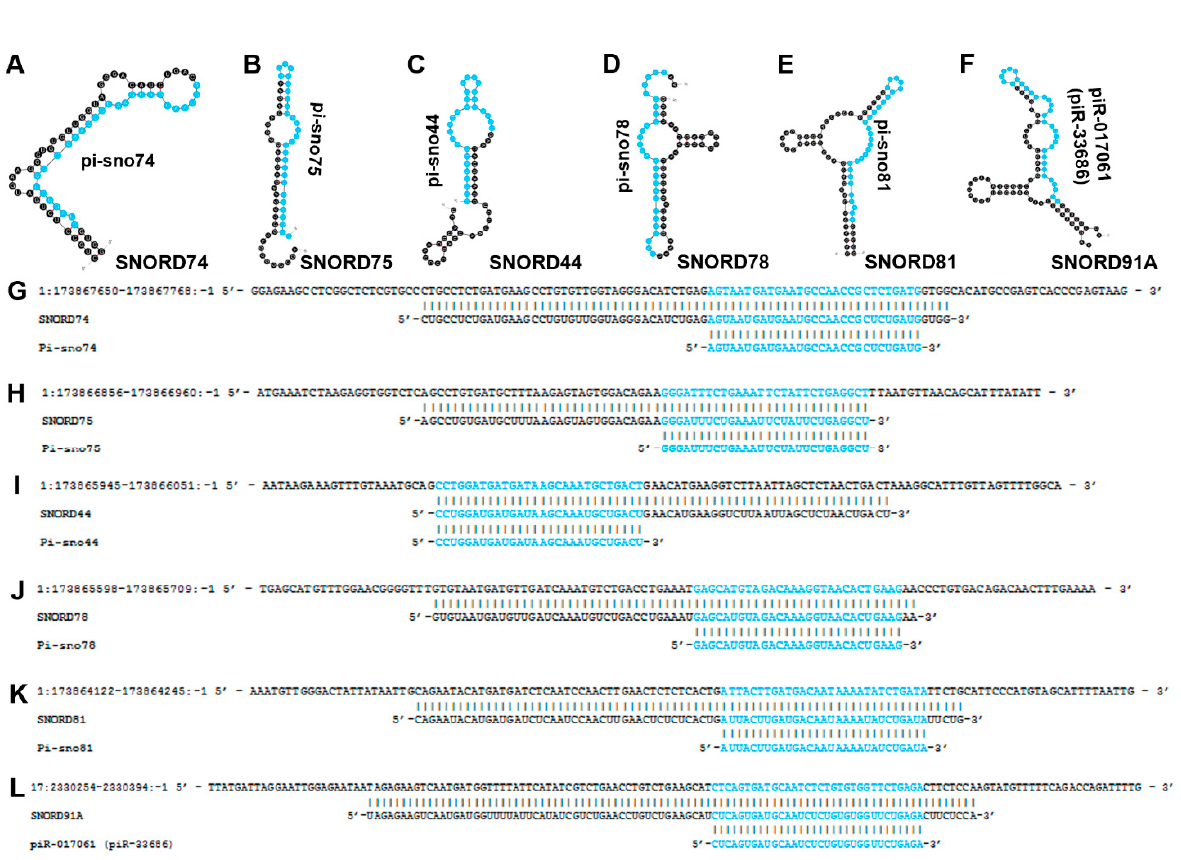
Figure 6. Sno-Derived Piwi-Interacting RNAs . ( A – F ) The most thermodynamically stable secondary structures of snoRNAs containing Piwi-interacting RNAs were obtained from mfold in which the piRNA sequence is highlighted in blue [20]. ( A ) pi-sno74 is embedded within SNORD74